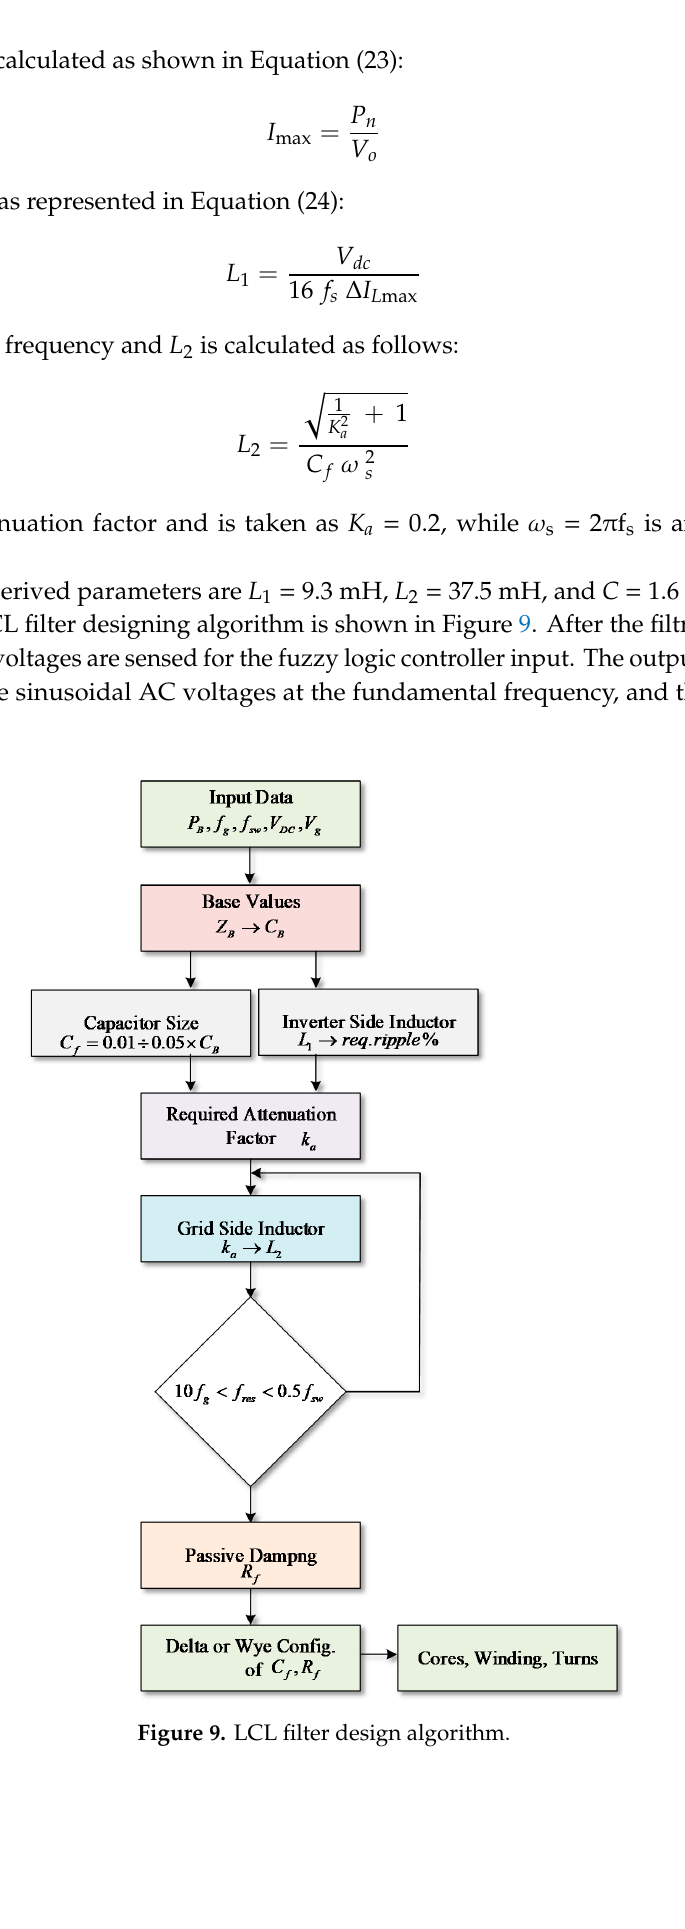
Table 3. Fuzzy logic rules for the voltage source inverter (VSI).